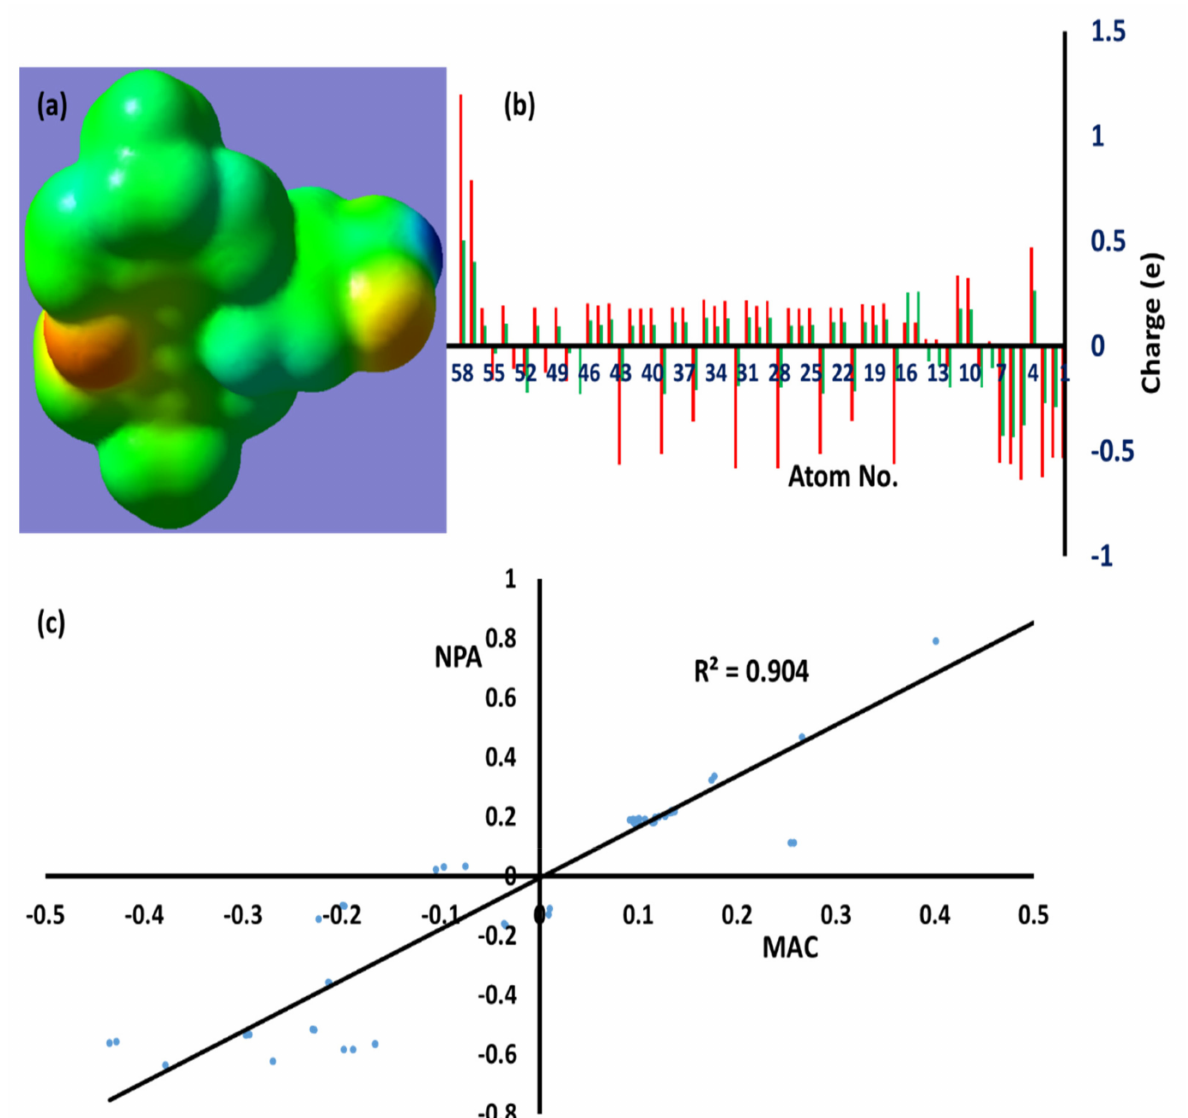
Figure 6. ( a ) MEP at B3LYP/6311G(d,P) level, ( b ) NPA (- - -) and MAC (- - -) charge, and ( c ) NPA/MAC graphical